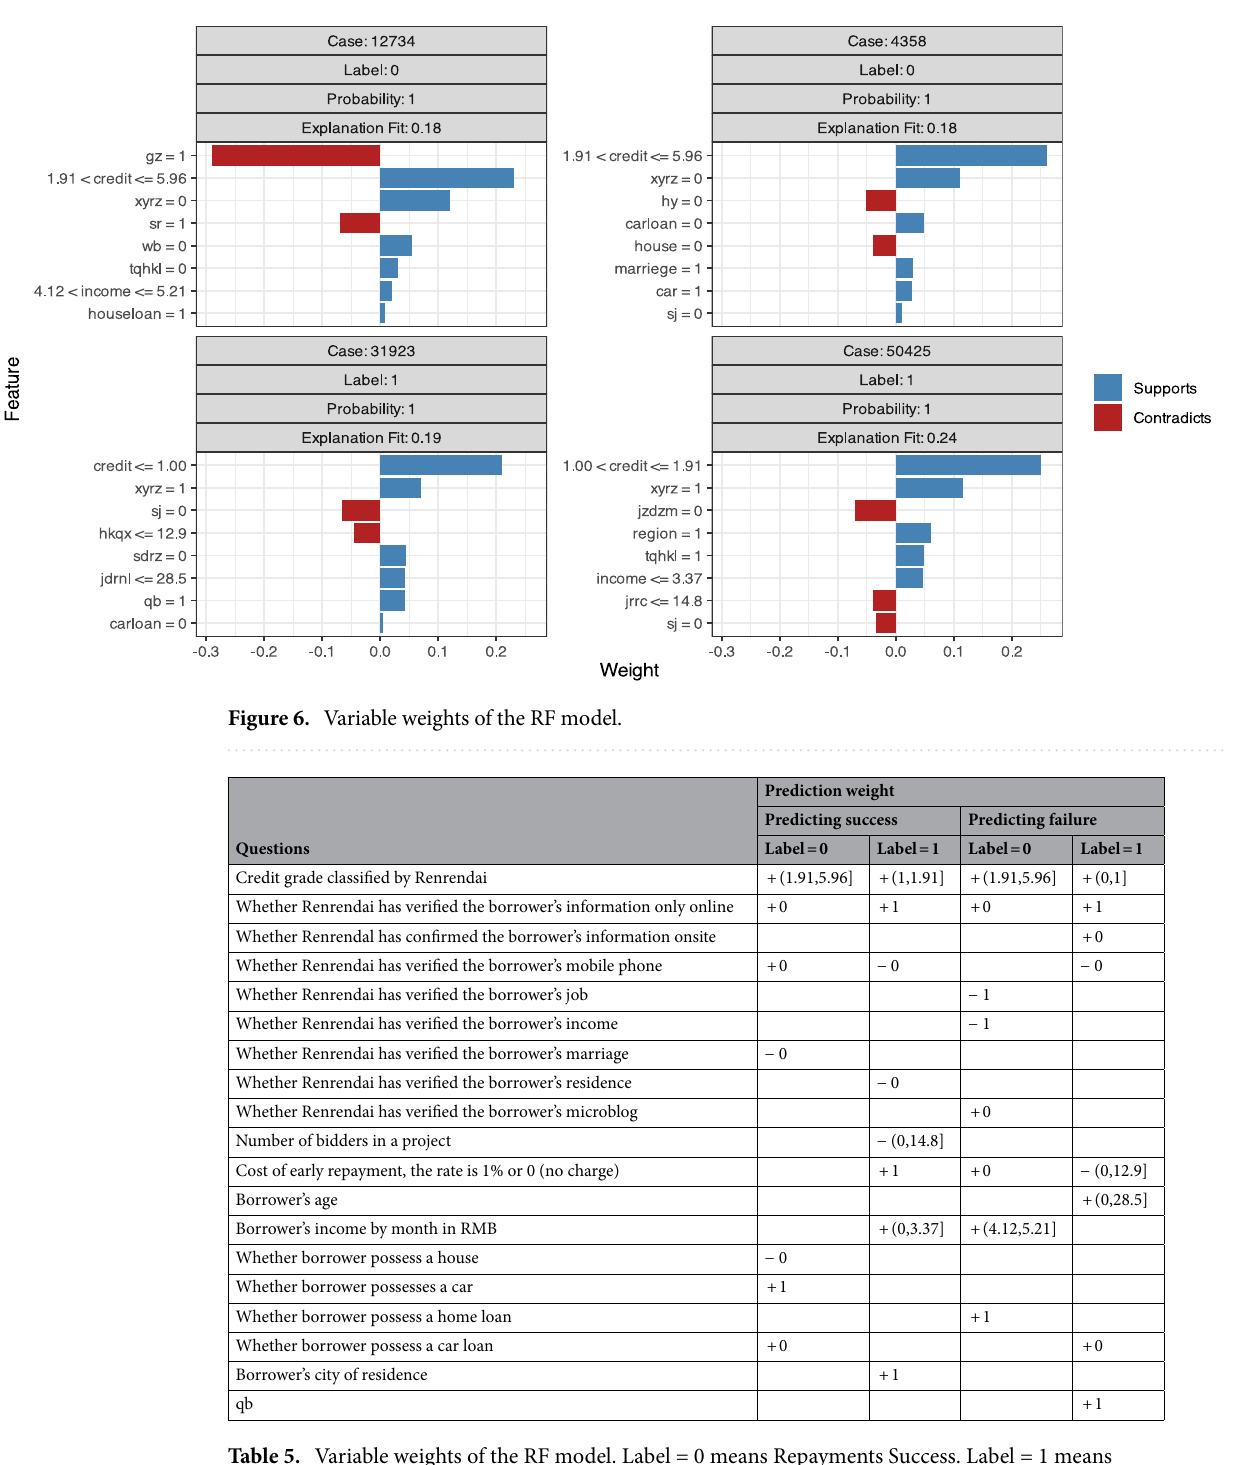
Table 5. Variable weights of the RF model. Label = 0 means Repayments Success. Label = 1 means Repayments Failure. ‘+’ means Supports, ‘−’ means contradicts.